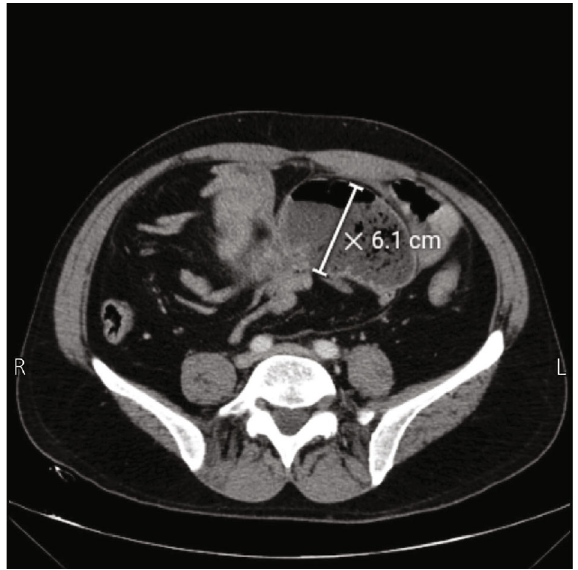
Figure 2: Axial image of contrast-enhanced CT shows dilated small bowel loop, a sign of small bowel